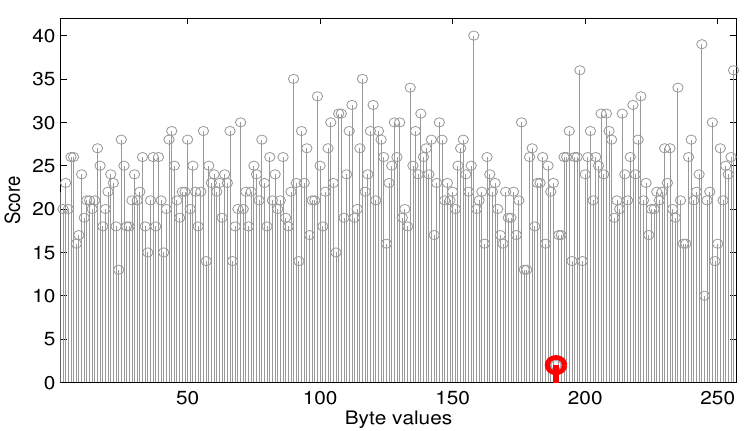
Figure 3. Key byte possible values with their associated discarding